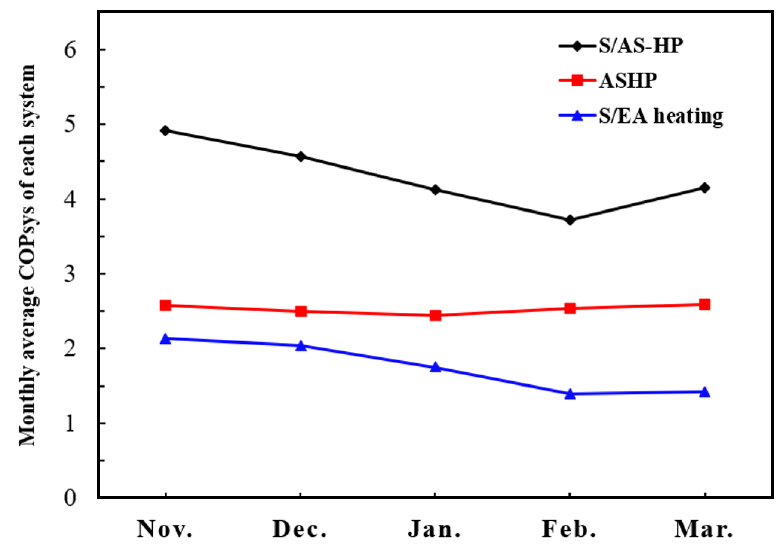
Figure 8. Comparison of the monthly average COP sys of each system.